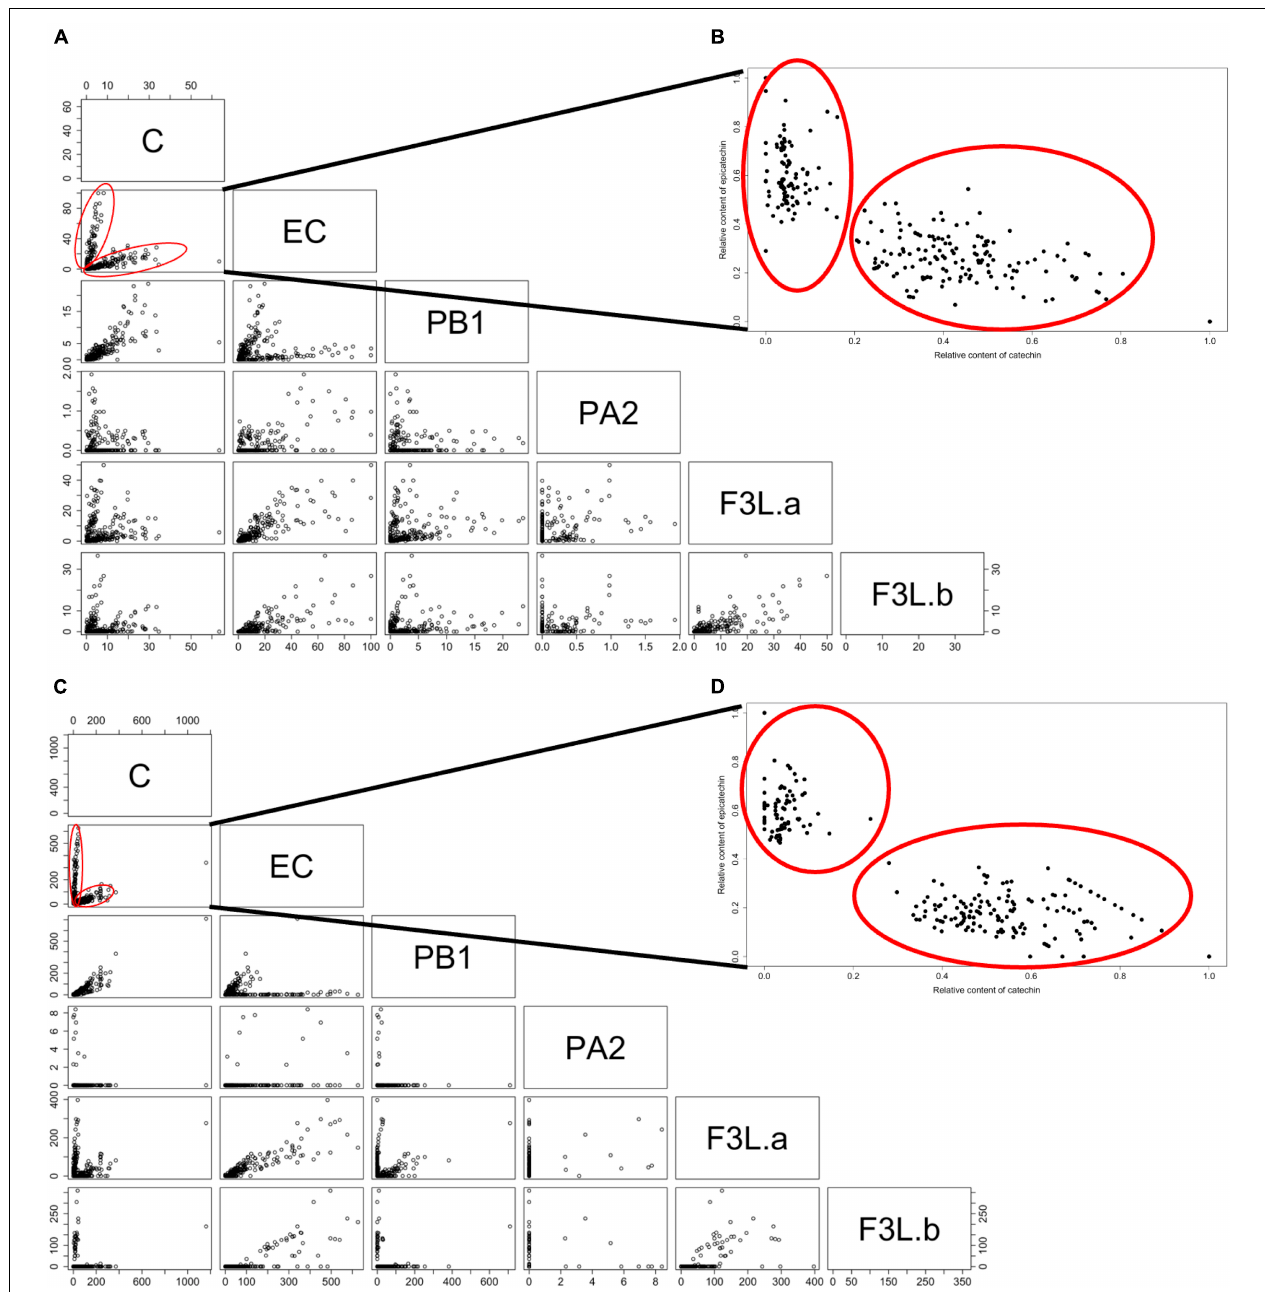
FIGURE 3 | Pairwise scatter plots among the six flavan-3-ols identified in the F1 population < ‘98–99’ × ‘Angeleno’ > in the flesh (A,B) and skin (C,D) . (A,C) Correspond to the scatter plots using the data obtained by the HPLC-DAD method. (B,D) Correspond to the scatter plots between the relative contents of C and EC (Refer to section “Materials and Methods”). Data correspond to the flesh and skin of the Japanese plum fruits in one season (T1). C, catechin; EC, epicatechin; PA2, proanthocyanidin A2; PB1, proanthocyanidin B1; FL3-a and F3L-b, two flavan-3-ol dimers denoted as “a” and “b”. Red circles indicate the subpopulations observed among the evaluated